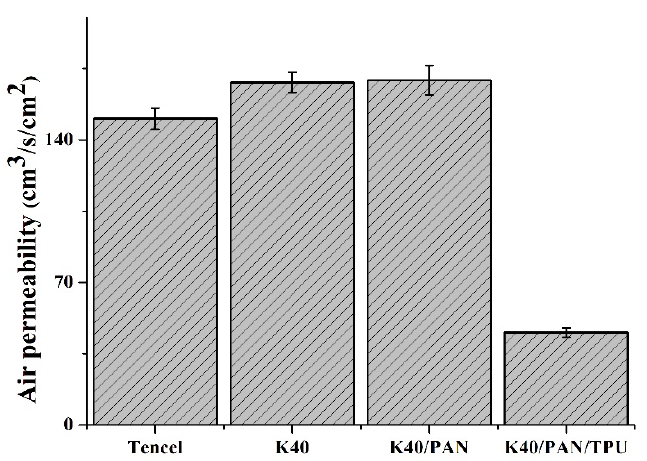
Figure 7. Air permeability of Tencel, K40, and K40/PAN/TPU lay-up compound